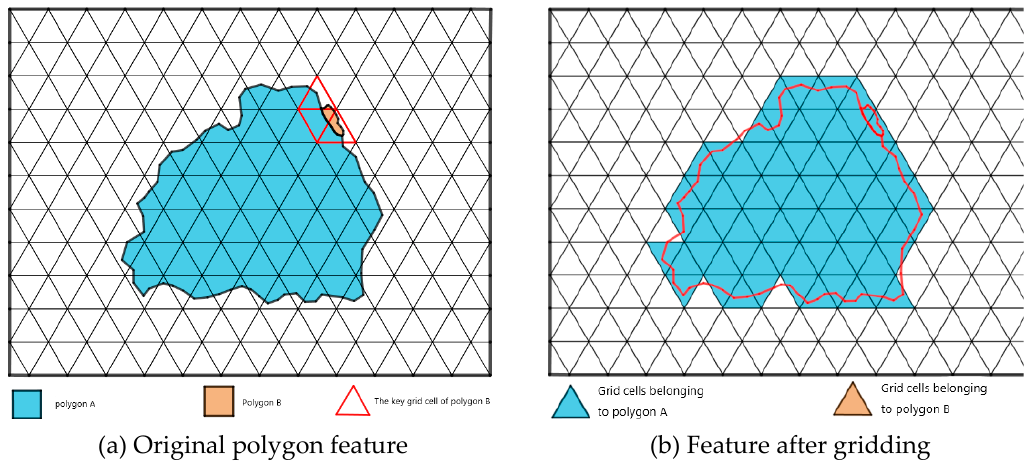
Figure 7. Polygon disappearance after gridding of polygon features.